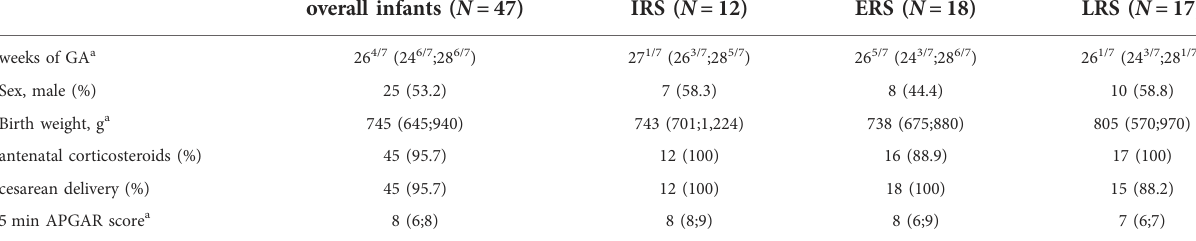
TABLE 1 Baseline characteristics.